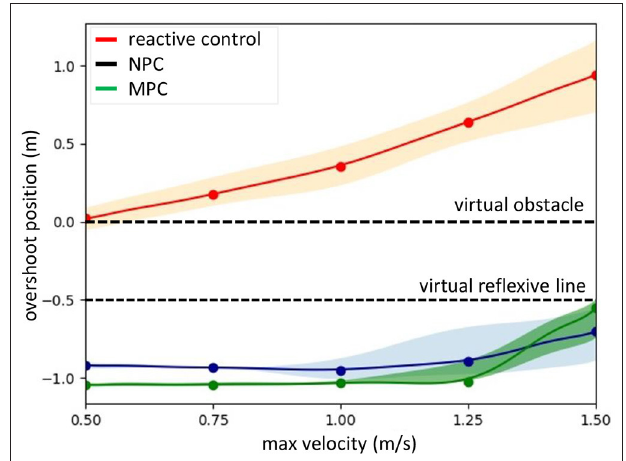
FIGURE 11 | Performance comparison of the real UAV ( Figure 4 ) when flying with neural proactive control (blue) and conventional reactive control (orange). The graph was plotted using the maximum overshoot position of the UAV while flying at different maximum speeds. The proactive control used the predictive signal with the optimal learned predictive weights or gains (obtained from Figure 7 ) while the reactive control used the reflexive signal with a fixed weight or gain (i.e., 1.0) for all speeds. To observe the distribution of the system we repeated seven times for each speed.